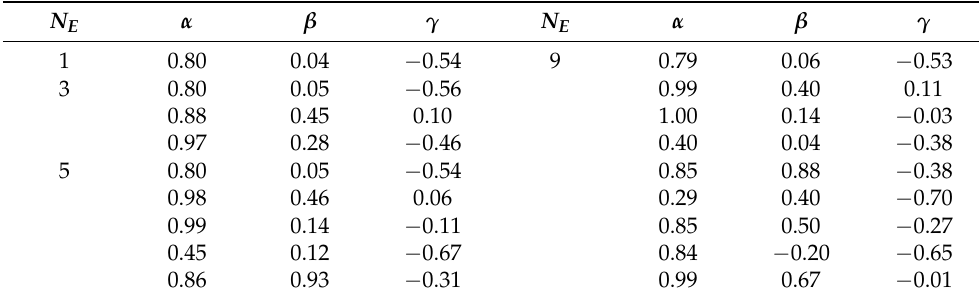
Table A1. Parameters used for the electron–positron correlation terms, i.e, terms with nonzero γ i , in positron–hydrogen wavefunctions with N E = 1,3,5 and 9 such